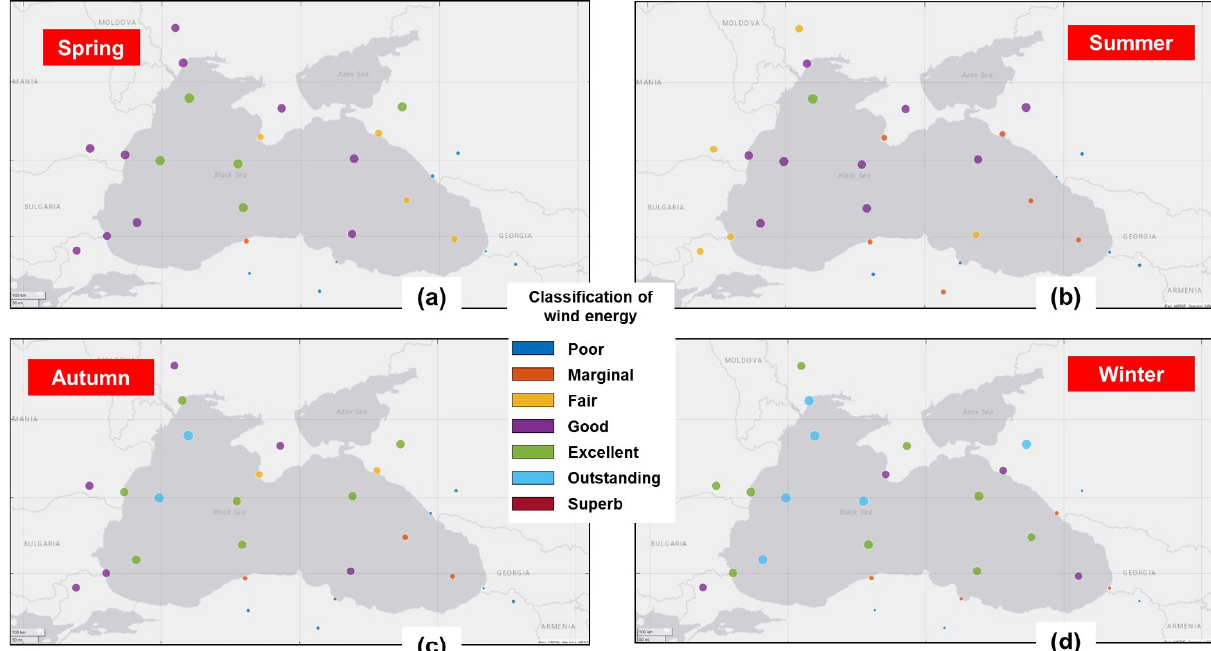
Figure 10. Seasonal values of the wind energy classification index associated with the 20-year time interval January 2002–December 2021, where: ( a ) spring; ( b ) summer; ( c ) autumn; ( d ) winter. These re- sults are using the U 100 parameter and are based on the methodology proposed in Costoya, et al.